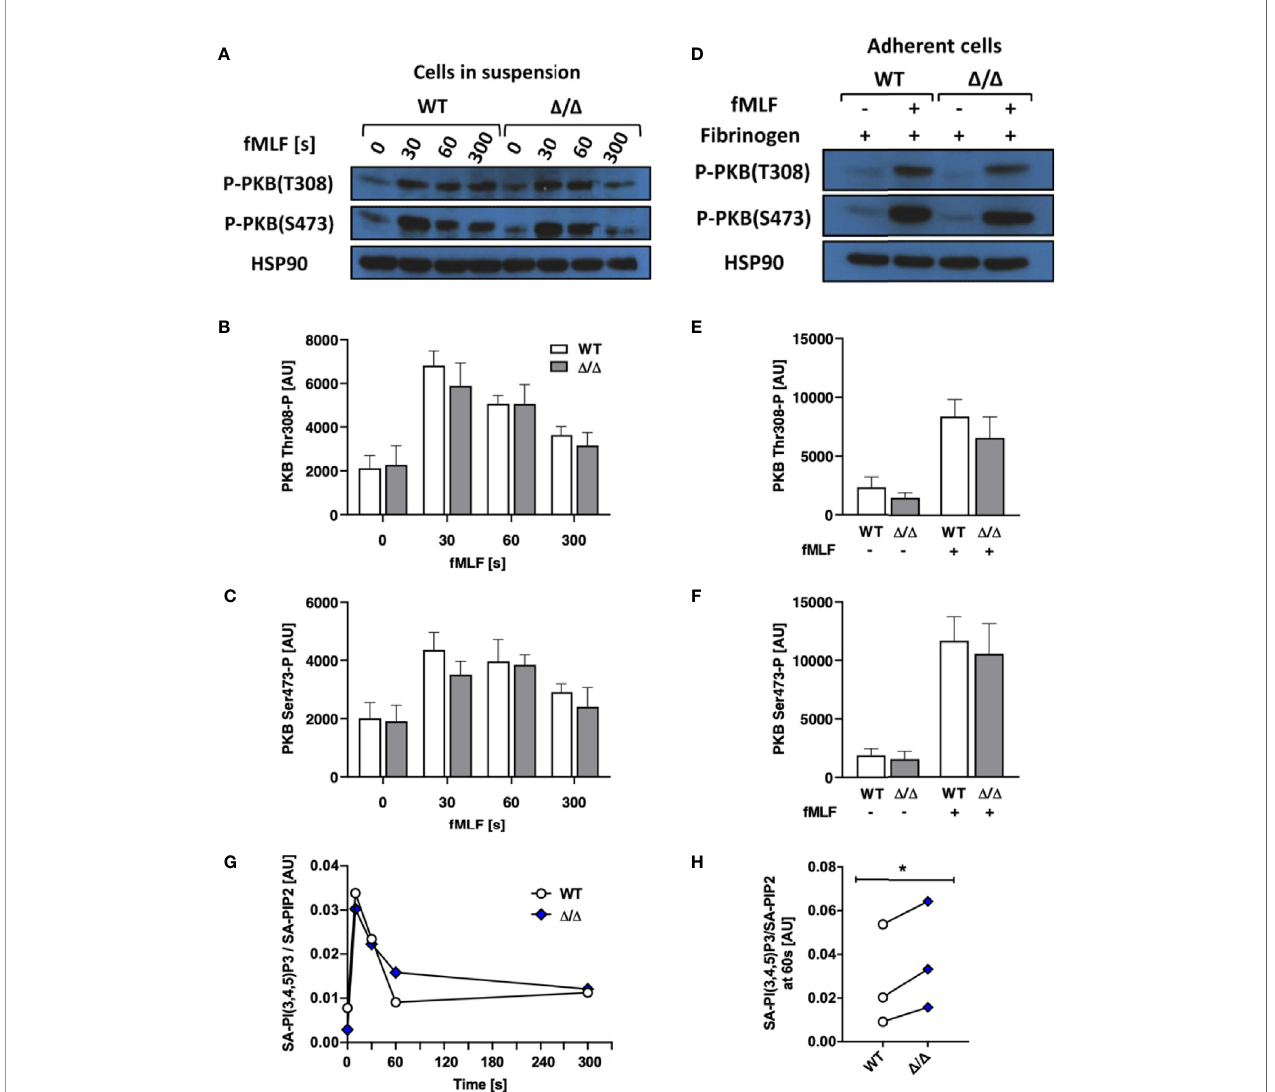
FIGURE 6 | SHIP2 D / D has no major effect on agonist-stimulated PKB phosphorylation or PIP3 production. Bone marrow-derived wild-type (WT) and Ship2 D / D ( D / D ) neutrophils were stimulated and (A – F) subjected to analysis of PKB phosphorylation. (A – C) Cells in suspension were stimulated with 1 m M fMLF at 37°C for the indicated times or (D – F) neutrophils were plated onto 150 m g/mL fi brinogen-coated tissue culture plastic in the presence of absence of 1 m M fMLF at 37°C for 19 minutes and processed for Western blotting. Blots were probed for phospho-PKB Thr 308 and Ser 473 with HSP90 as a loading control. Representative blots are shown (A, D) and densitometrical analyses combining 5 (B, C) or 4 (E, F) separate experiments are plotted (mean ± SEM). (G, H) Neutrophils were stimulated with 10 m M fMLF for the indicated times at 37°C, and PIP3 generated was analyzed by mass spectrometry. (G) A representative experiment, presenting stearoyl/ arachidonyl (SA) PIP3 divided by SA-PIP2. (H) At the 60 s timepoint, Ship2 D / D neutrophils reproducibly contained subtly increased PIP3. (G, H) , Symbols represent individual experiments. Statistical analysis was by 2-way ANOVA with multicomparison post-hoc test (B, C, E, F) and a paired t test (H) . * p <